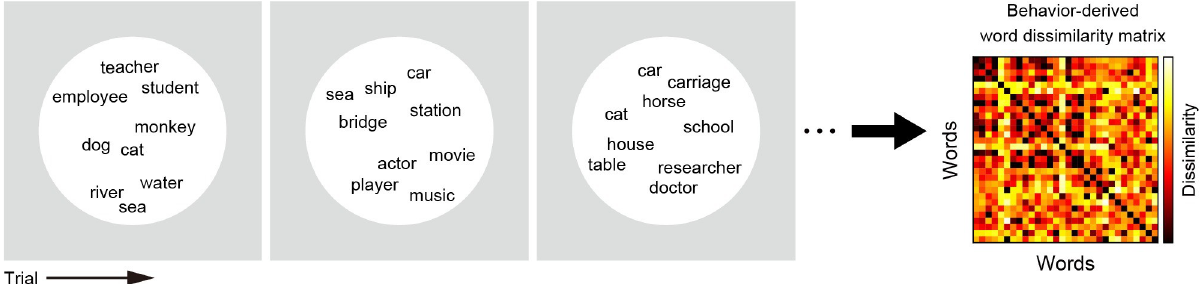
Fig 2. Word-arrangement task and behavior-derived word dissimilarity. To evaluate the word dissimilarity structure derived from human behavior, we conducted psychological experiments in which each participant performed a word-arrangement task. On each trial of this task, participants were required to arrange multiple ( � 60) words in a two-dimensional space according to the semantic relationship of those words. After each participant completed � 1 h of this task, a behavior-derived word dissimilarity matrix was established using inverse multidimensional scaling (see Methods for more